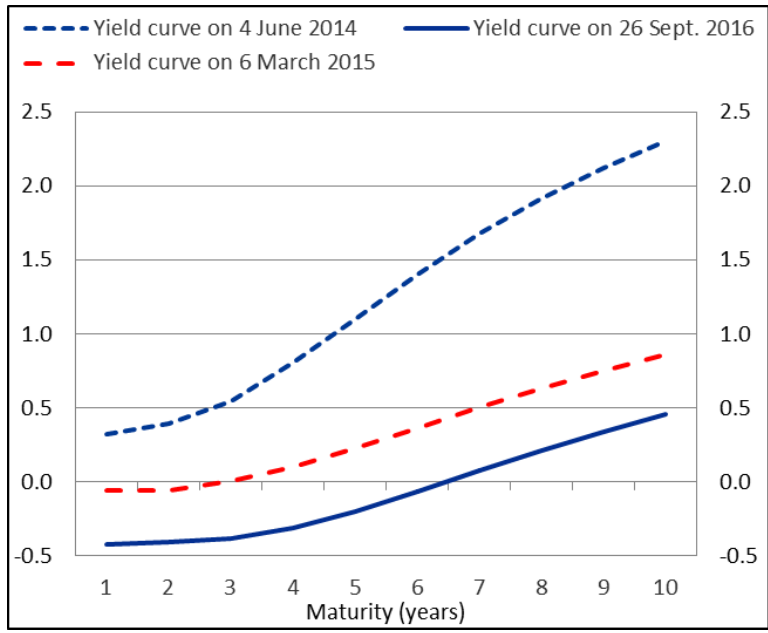
Figure 5. Euro area average government bond yield curve (synthetic yields in percentages per annum and maturity in years). Source: Bloomberg, ECB.